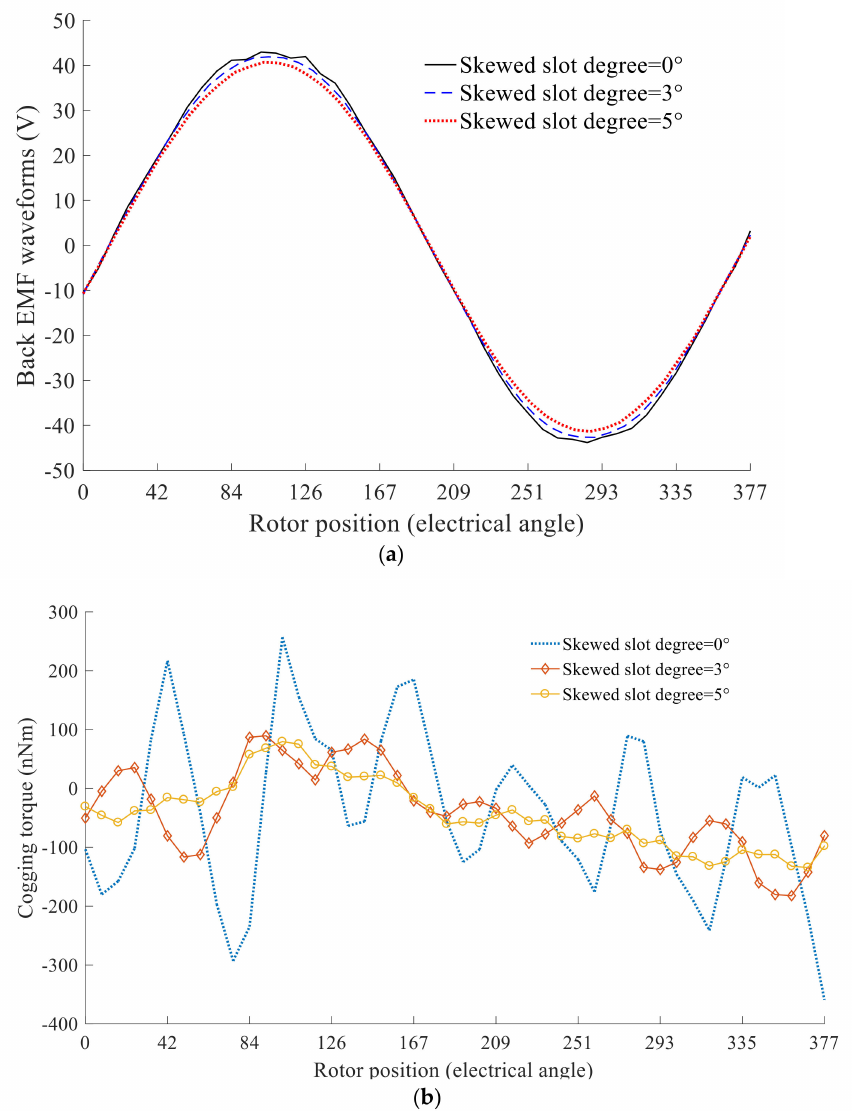
Figure 6. The comparison of back EMF waveform and cogging torque of the VFMPM machine in enhanced flux condition. ( a ) Back EMF waveform; ( b ) Cogging